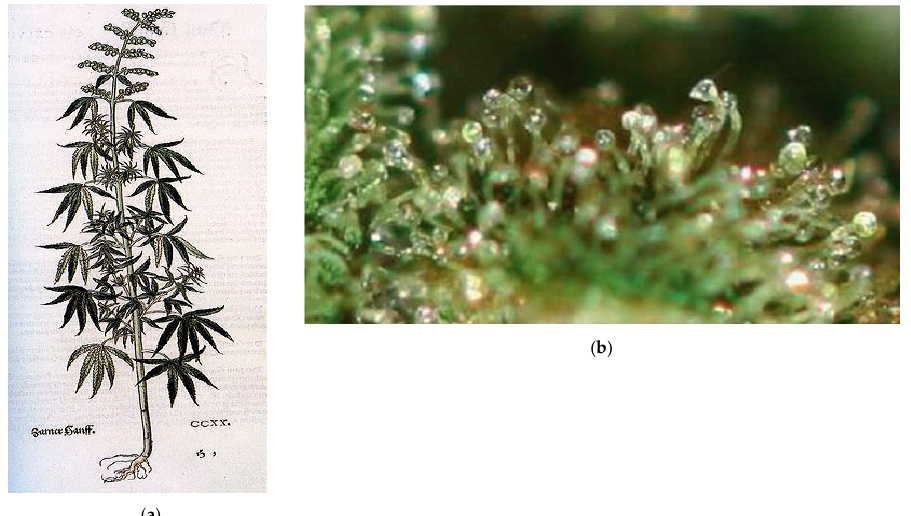
Figure 1. ( a ) Illustration of Cannabis Sativa L. from Heinrich Füllmaurer, 1543 ( b ) Cannabis Sativa L. glandular trichomes, photography by Ethan Budd Russo, reproduced by permission of Wiley-VHCA AG, Zurich, Switzerland [15].